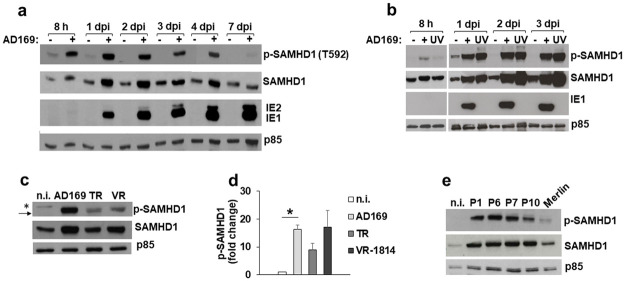
SAMHD1 is phosphorylated at T592 in HCMV-infected cells.a) SAMHD1 phosphorylation at T592 (pT592) was analyzed by immunoblotting with a specific antibody in cell lysates of HFFs not infected or infected with AD169 at an MOI of 1 for the indicated time points. Expression of IE1/IE2 viral antigens was used as control for infection, while p85 was the loading control. A representative experiment out of six is shown. b) pT592-SAMHD1 was analyzed as in panel a), in parallel with an UVB-inactivated AD169 (UV), for the indicated time points. A representative experiment out of two is shown. c) pT592-SAMHD1 was analyzed as in panel a), in HFFs not infected or infected with the indicated strains (MOI 1, 3 dpi). A representative experiment out of three is shown. d) The relative amount of pT592-SAMHD1, normalized to that of p85, was determined by densitometric analysis and is relative to that of n.i. cells, which was arbitrarily set as 1. Data are expressed as mean ± SE of at least three independent experiments. *, p < 0.05. e) pT592-SAMHD1 levels in HFFs infected with HCMV clinical isolates (P1, P6, P7 and P10) or with Merlin. Data derive from one representative experiment out of two. *, unspecific band; black arrow, pT592-SAMHD1 specific band.